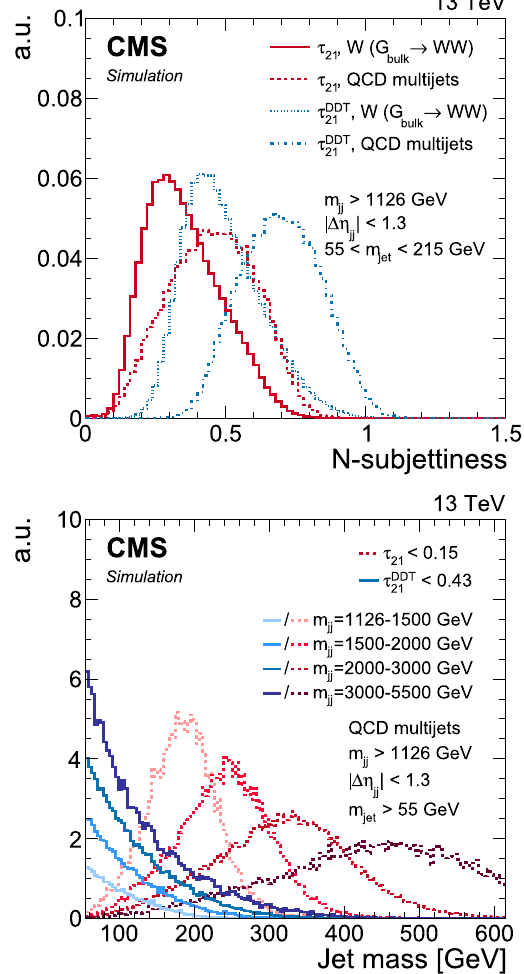
Fig. 2 Distribution of the N -subjettiness discriminants ( τ 21 and τ DDT ) Fig. 1 The τ 21 (upper) and τ DDT (lower) profile dependencies on 21 21 for W-jets and quark/gluon jets from QCD multijet events (upper). Dis- ρ (cid:3) = ln ( m 2 /( p μ)) examined in QCD multijet events simulated with T jet tributions in the jet mass of QCD multijet events for four m jj bins in > 200GeV pythia . A fit to the linear part of the spectrum for p T the range 1126–5500GeV after a cut on τ 21 and τ DDT corresponding yields the slope M = − 0 . 080, which is used to define the mass- and 21 to the same mistag rate of about 2% (lower). For both discriminants, = τ − M ρ (cid:3) p T -decorrelated variable τ DDT 21 21 darker colours correspond to higher m jj ranges. The distributions are arbitrarily scaled for better readability. The analysis selections applied to derive these distributions are specified in the plots. For this analysis ≤ 0 . 43 is the working point of τ DDT 21